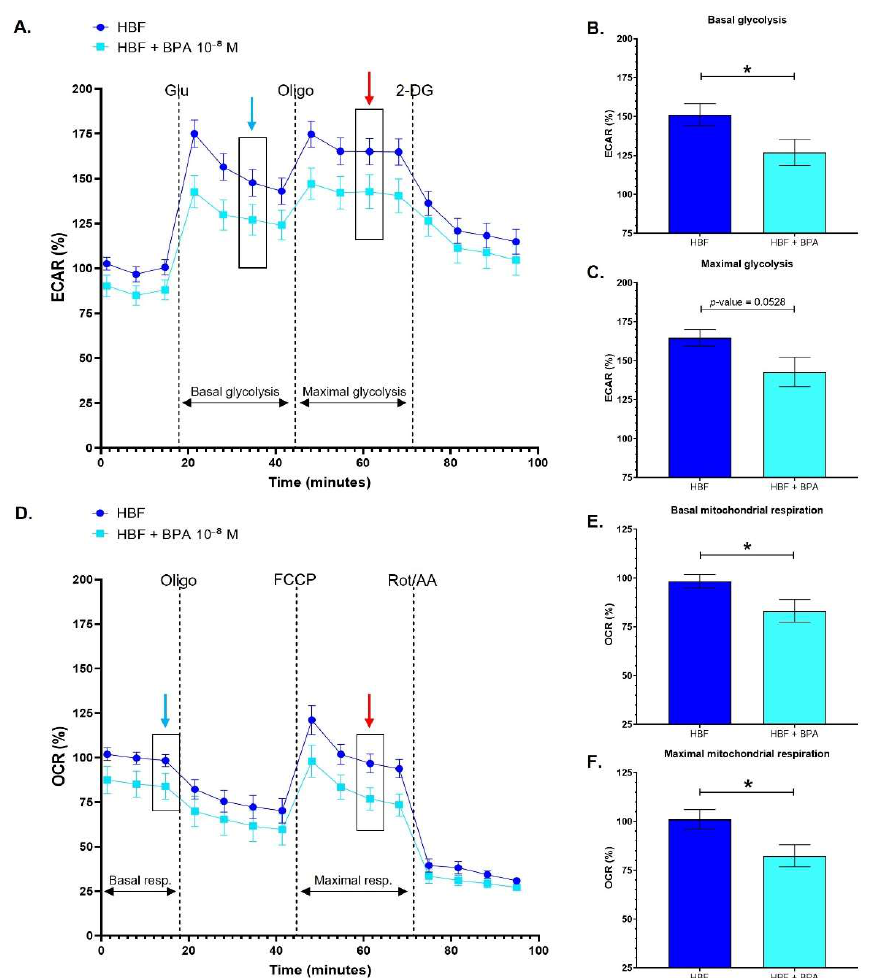
Figure 2. Healthy human bladder fibroblasts exhibit a decreased glycolytic and mitochondrial me-